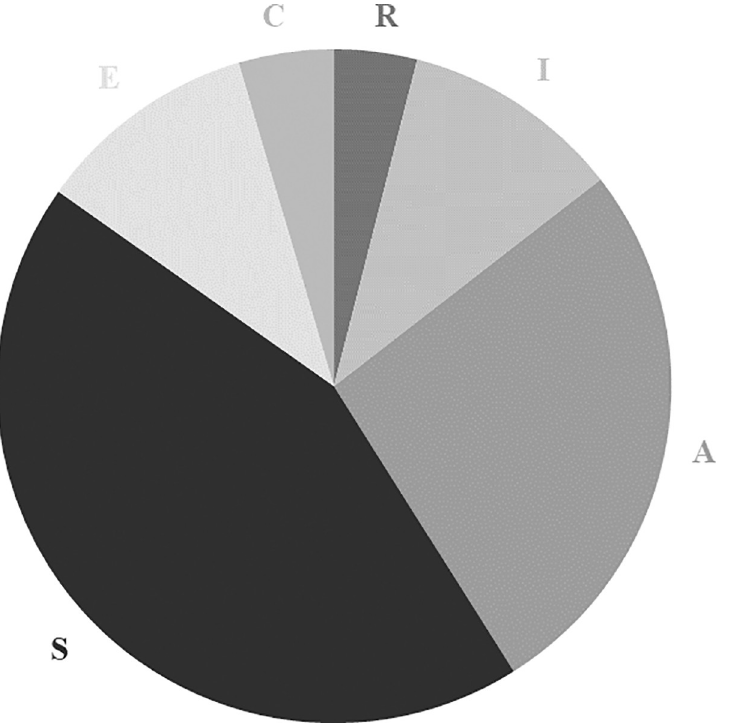
Fig 3. Distribution of one-dimensional interest types among young